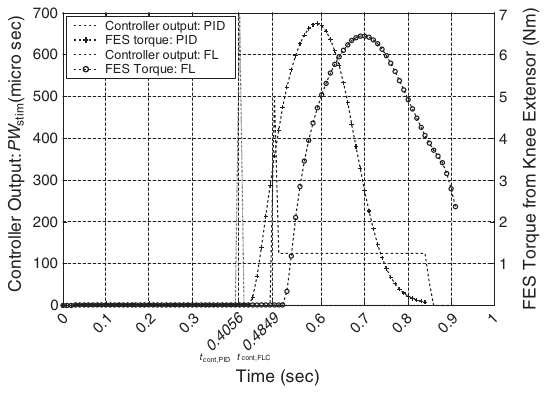
Fig. 17. Controller output and resultant FES induced active torque from PID and FL controller (control